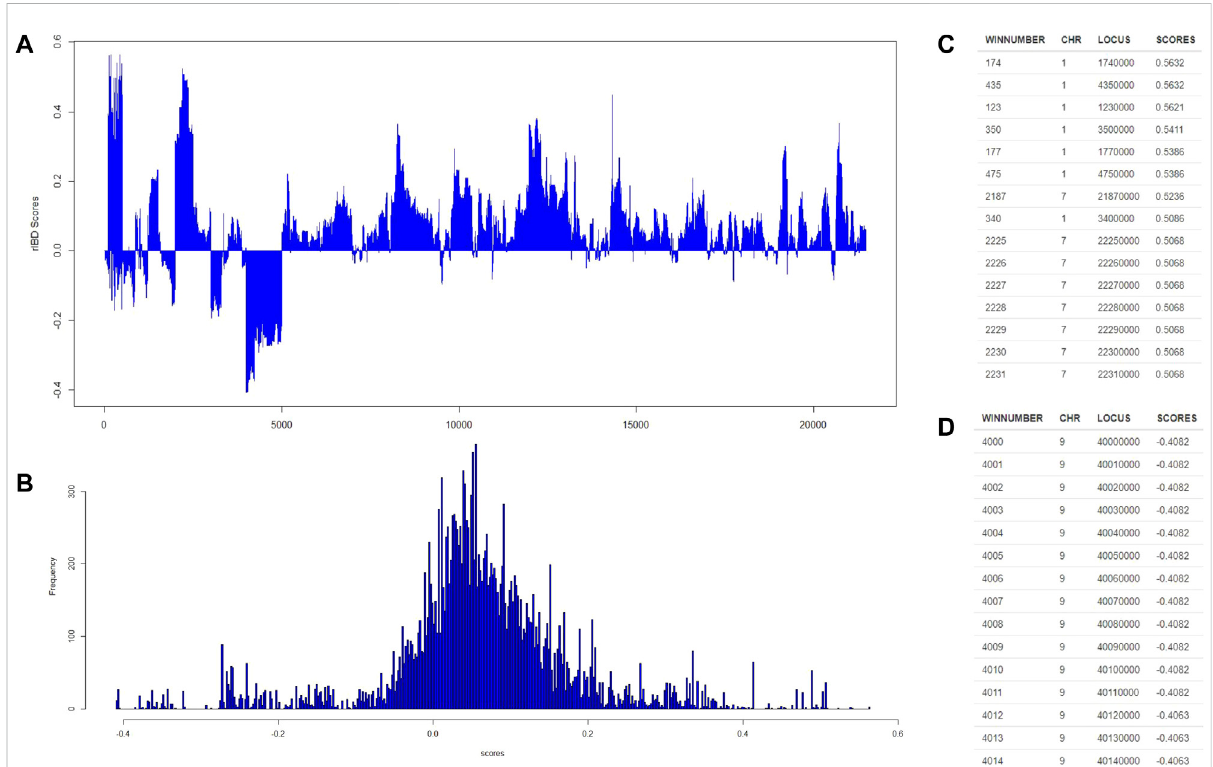
FIGURE 2 The distribution of rIBD scores across the chromosome and the signi fi cant positive or negative rIBD scores lists. (A) The calculated rIBD scores across the chromosome; (B) Tthe distribution of the rIBD scores; (C) The list of the signi fi cant positive rIBD scores list; (D) The list of the signi fi cant negative rIBD scores